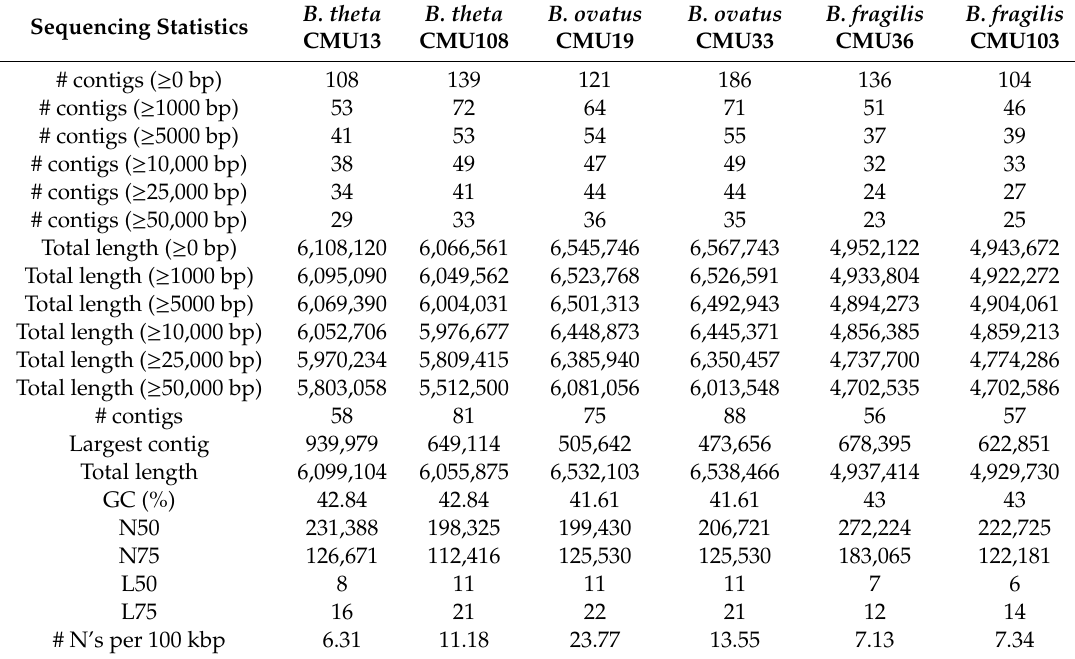
Table 2. Whole genome sequencing SPAdes assembly